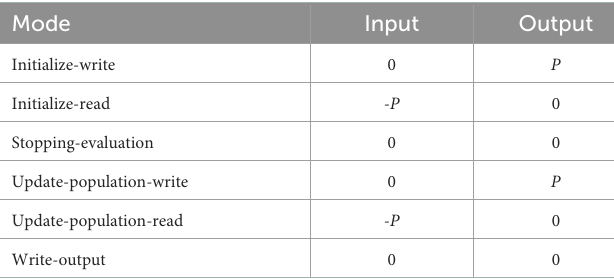
TABLE 1 Dataflow table for the PSO Core